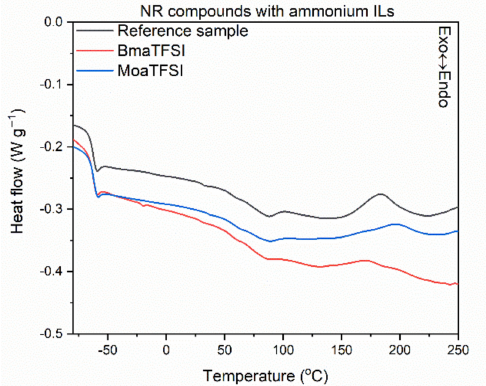
Figure 3. DSC curves of NR compounds containing ammonium ILs with TFSI